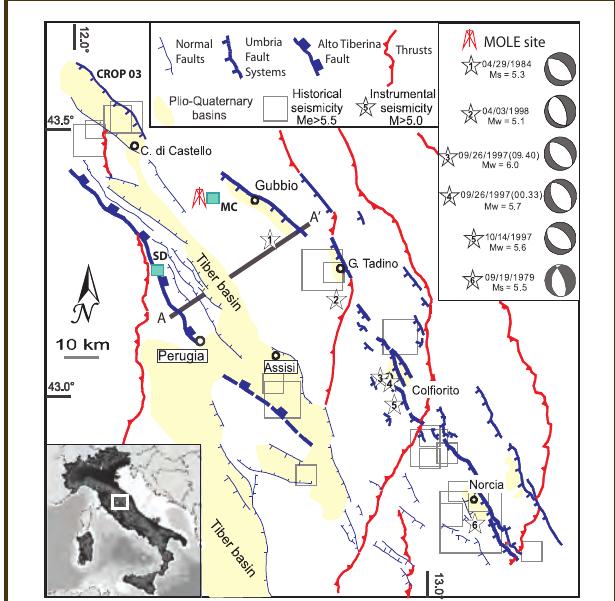
Figure 1. Schematic seismotectonic map of the Umbria-Marche area (modified after Mirabella et al., 2004). Historical earthquakes (gray squares) between 461 BC and 1997 AD (from Boschi et al., 2000). Focal mechanism solutions: (1) Gubbio earthquake (Haessler et al., 1988); (2) Gualdo Tadino earthquake, and (3, 4, 5) Colfiorito sequence (Ekström et al., 1998); (6) Norcia earthquake (Deschamps et al., 2000). SD (San Donato) and MC (Monte Civitello) well sites with A-A’ represent the section of Figure